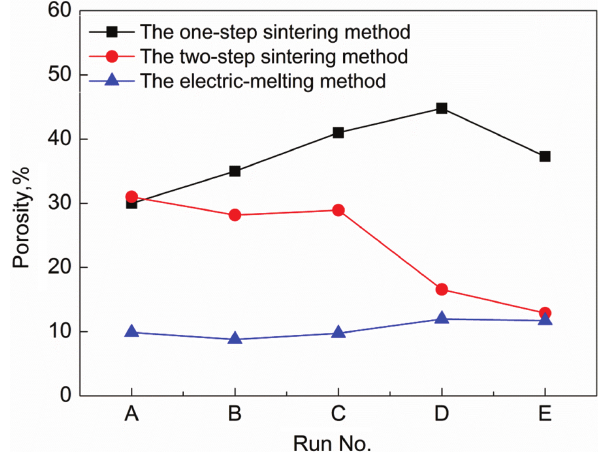
Figure 4: Porosity ratio data of MgAl 2 O 4 spinel refractory